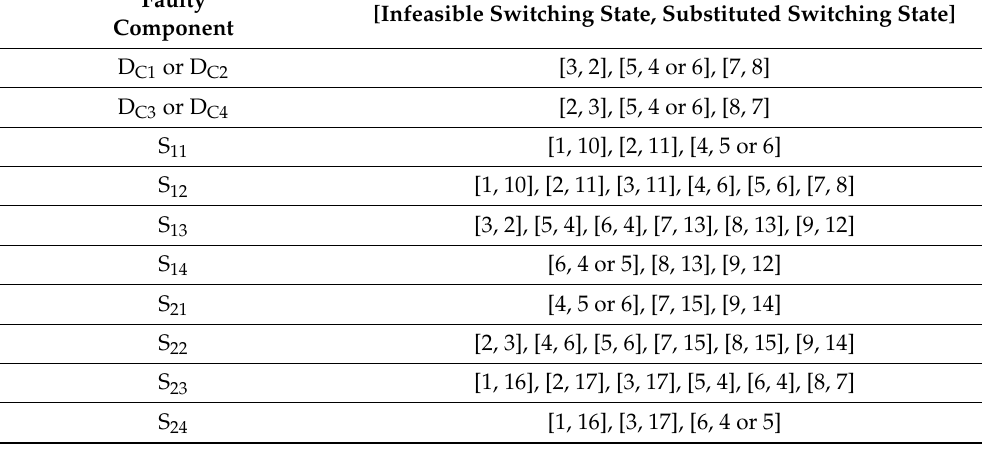
Table 4. Modification of the switching states to realize fault-tolerant operation.